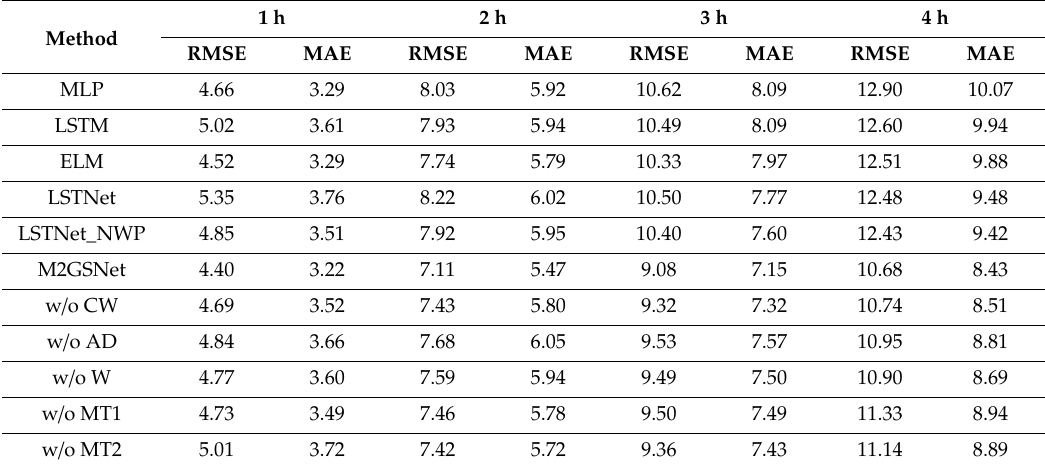
Table 2. Prediction results of di ff erent methods